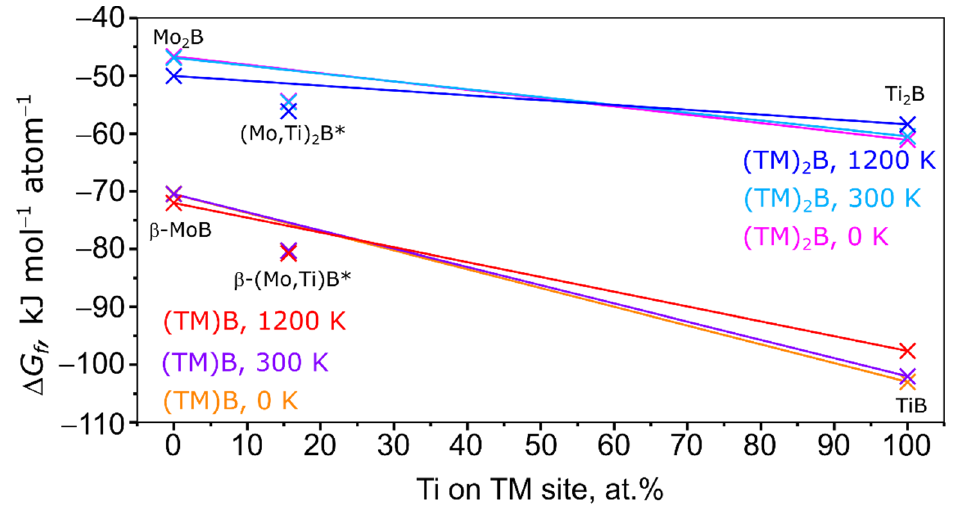
Figure 7. Enthalpy of formation of the (TM)B and (TM) 2 B series at 0, 300, and 1200 K. 0 at.% Ti: β -MoB and Mo 2 B, 15.63 at.% Ti: SQS cell of (Mo,Ti) 2 B, 43.75 at.% Ti: SQS cell of β -(Mo,Ti)B, 100 at.% Ti: TiB and Ti 2 B. Solid lines serve as a guide to distinguish stable (below that line) and unstable (above that line) disordered phases. *: SQS cells.